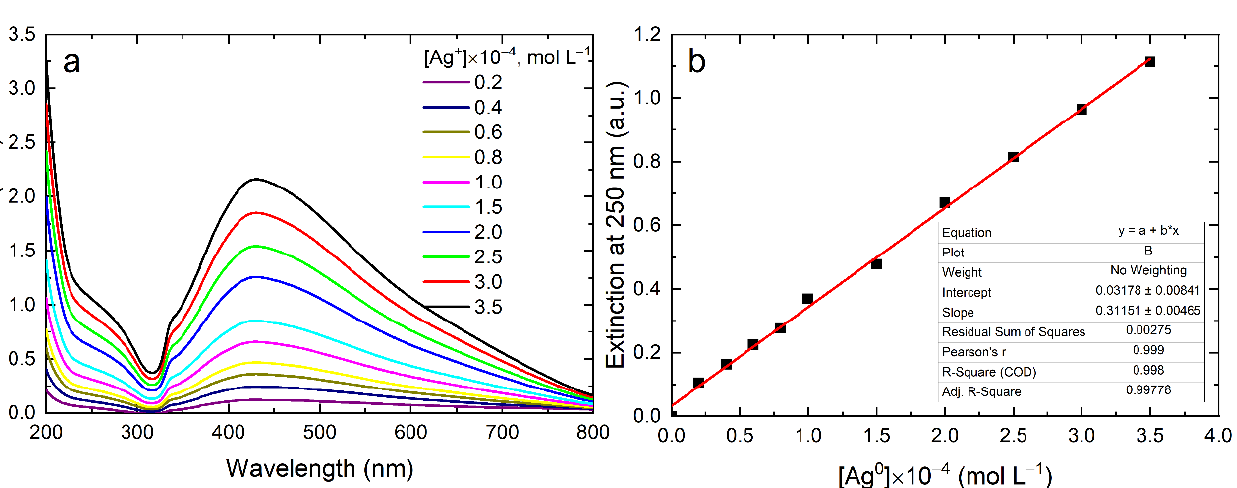
Figure 6. Variation of absorption of the silver hydrosol during its formation by the reduction of Ag + with NaBH 4 in the presence of NaPp ( a ); IBT absorption at 250 nm as a function of Ag 0 concentration ( b ). Solution: Ag + (0.4–3.5) × 10 − 4 mol L − 1 and NaPp 2 × 10 − 4 mol L − 1 ( b ). Optical path length: 10 mm.